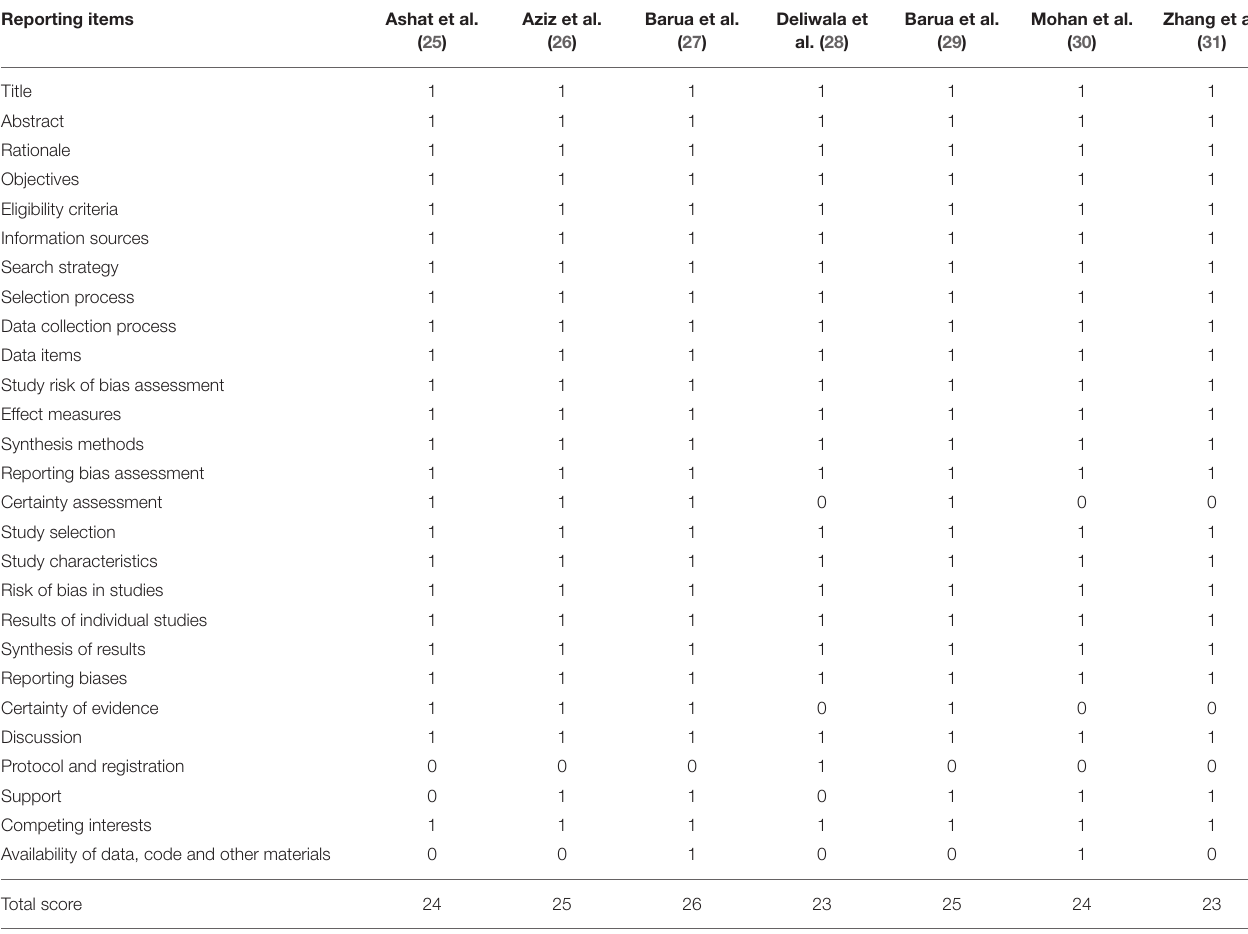
TABLE 6 | PRISMA criteria for each included